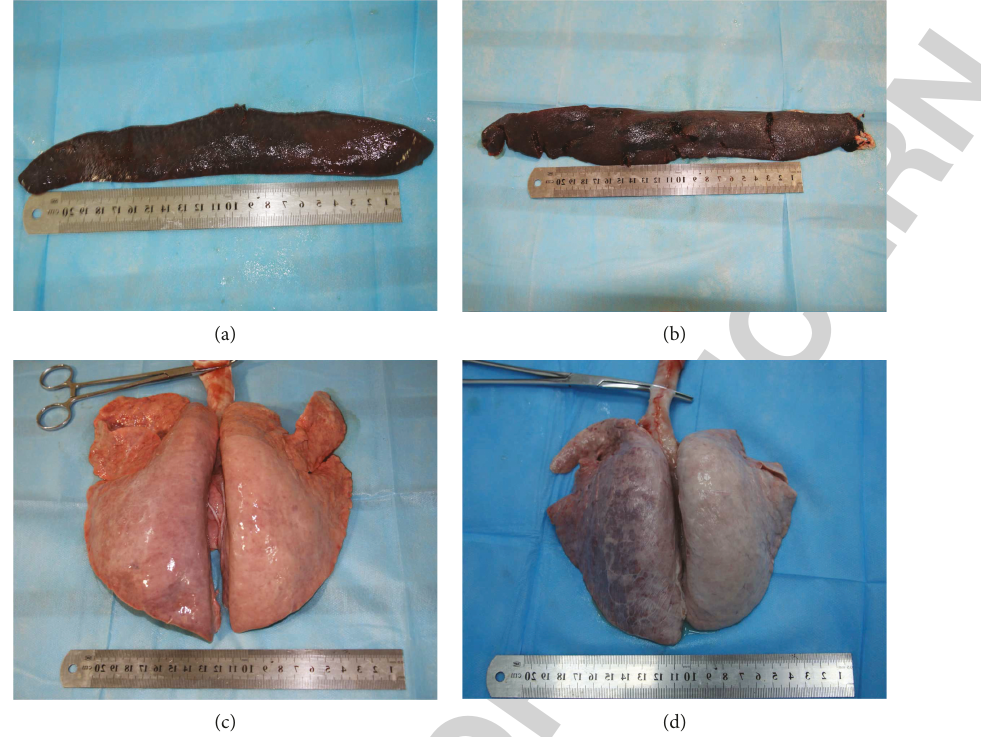
Figure 6: Typical injuries of the thoracoabdominal organs of the pigs that sustained CCI. (a) Ruptures of the spleen in group I, with 2-3 small wounds in the spleen indicated; (b) multiple wounds of the spleen in group II in which the wounds were more wider and deeper than those of group I; (c) there was no obvious damage to the lung of the pigs in group I after the impact; (d) di ff use hemorrhage of the lung of the pig in group II, in which the lamellar hemorrhage was observed.